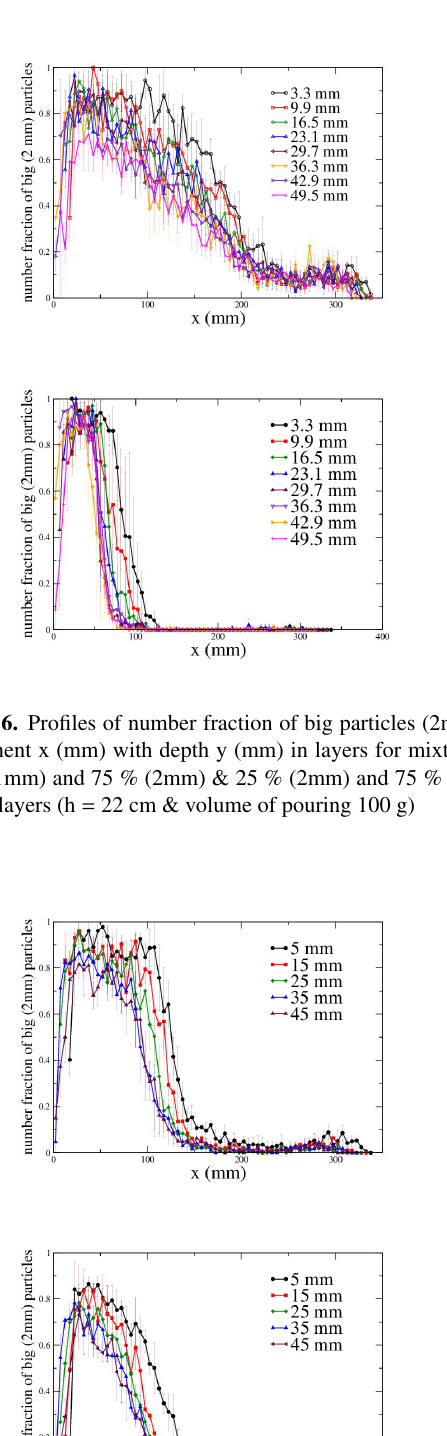
Fig.8 (left) shows comparison of number fraction of big particles (2 mm) vs component x (mm) for surface layer. As % of big particles in mixture is increases (from 25, 50 and 75%), number fraction also increases accord-